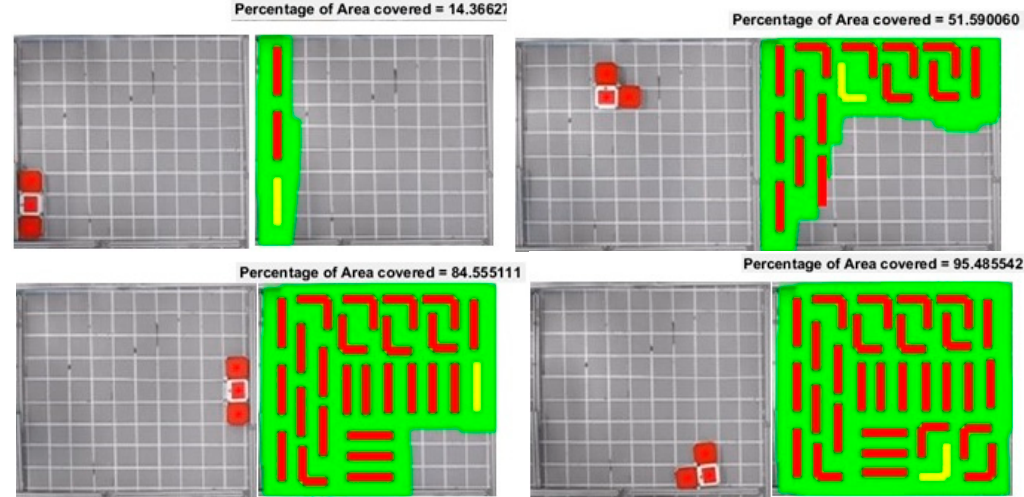
Figure 16. Experiments validating application of Theorem 1.